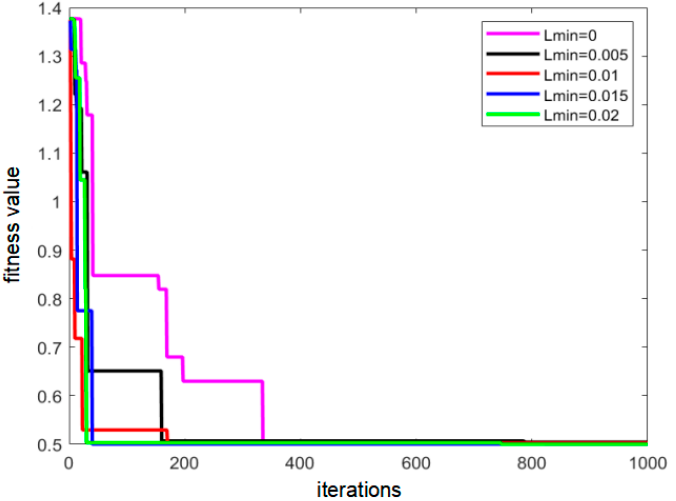
Figure 9. Schematic diagram of algorithm performance under different minimum L min values.